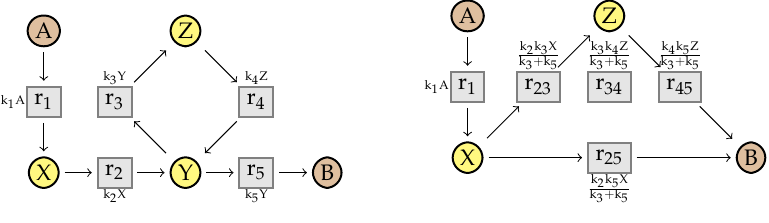
Figure A1. Networks W 0 ( left ); and W (right